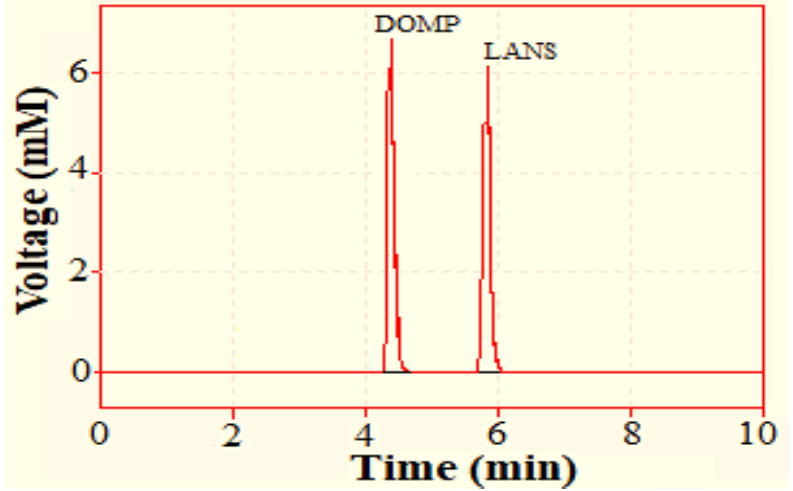
Figure 2. Chromatogram showing retention time (R t ) of domperidone (DOMP) (4.375 min) and lansoprazole (LANS) (5.726 min). lansoprazole (LANS) (5.726